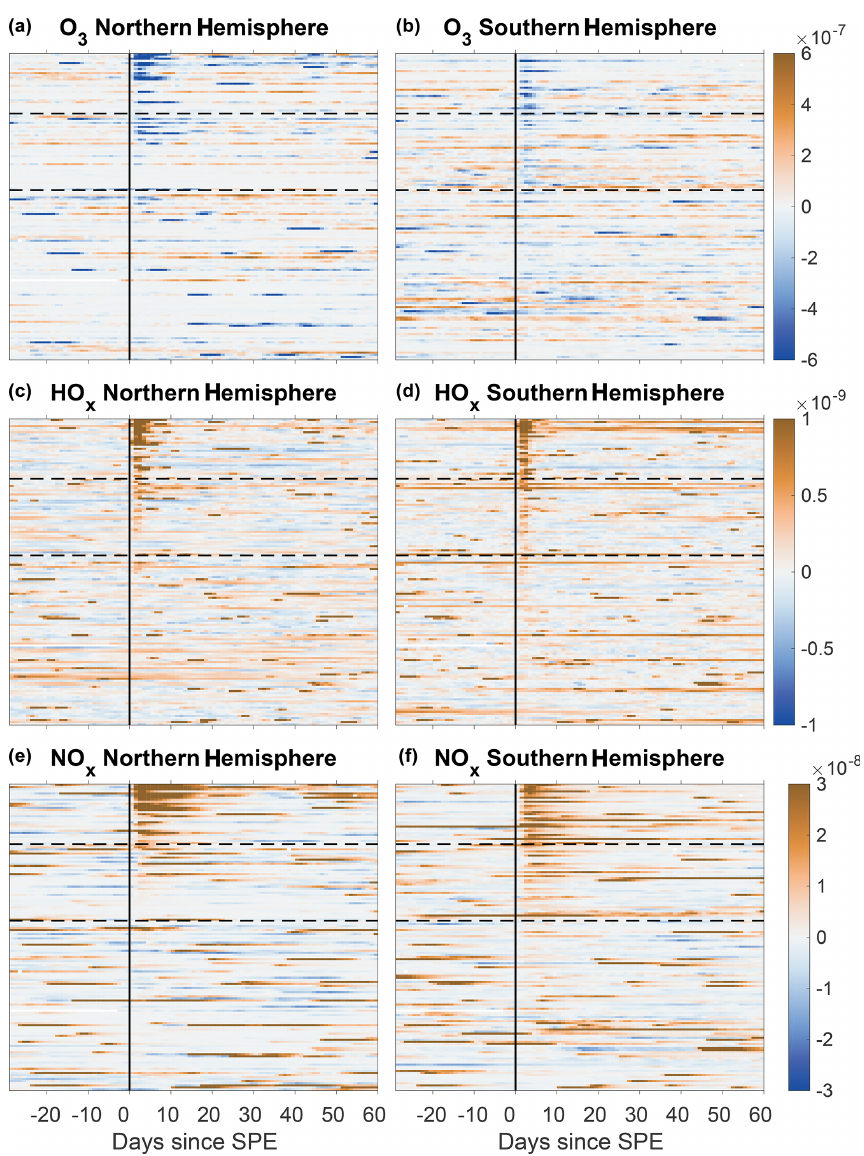
Figure 10. (cid:100) WD of individual SPEs at 0.05hPa pressure level, sorted by the increasing SPE magnitude for the northern (a, c, e) and southern (b, d, f) polar caps. Dashed lines represent the 100 (bottom line) and 1000 (top line) pfu